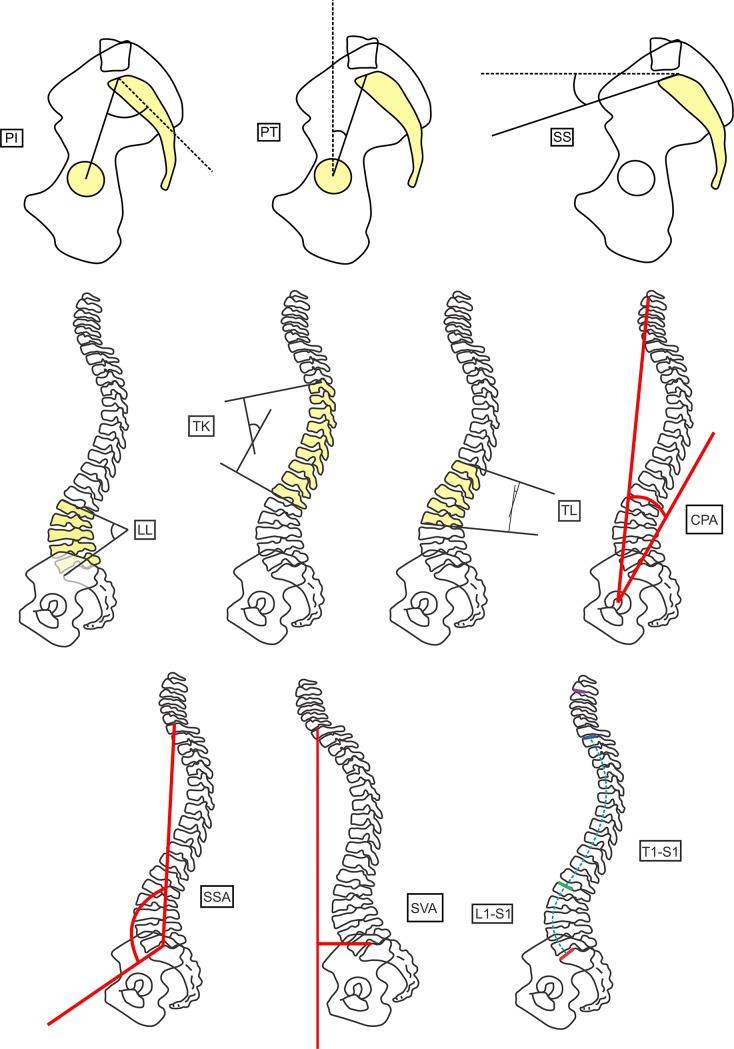
Spinopelvic parameters measured.Superior line: pelvic incidence—PI (left); pelvic tilt—PT (center); sacral slope—SS (right). Middle line: lumbar lordosis—LL (left); thoracic kyphosis—TK (left-middle); thoracolumbar alignment—TL (middle-right); C2 pelvic angle—CPA (right). Inferior line: spinosacral angle—SSA (left); sagittal vertical axis—SVA (center); L1S1 and T1S1 length (right).